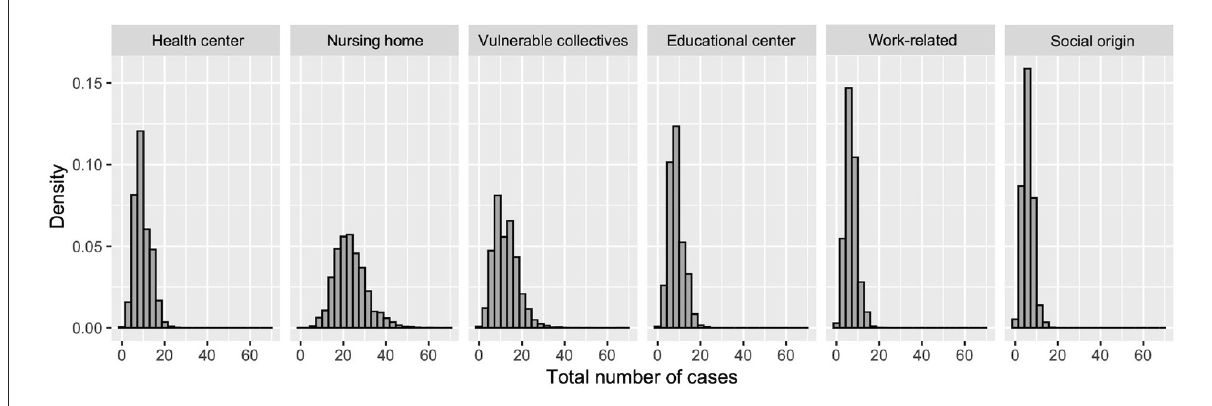
FIGURE9 Probability histogram of expected cases for each type of outbreak